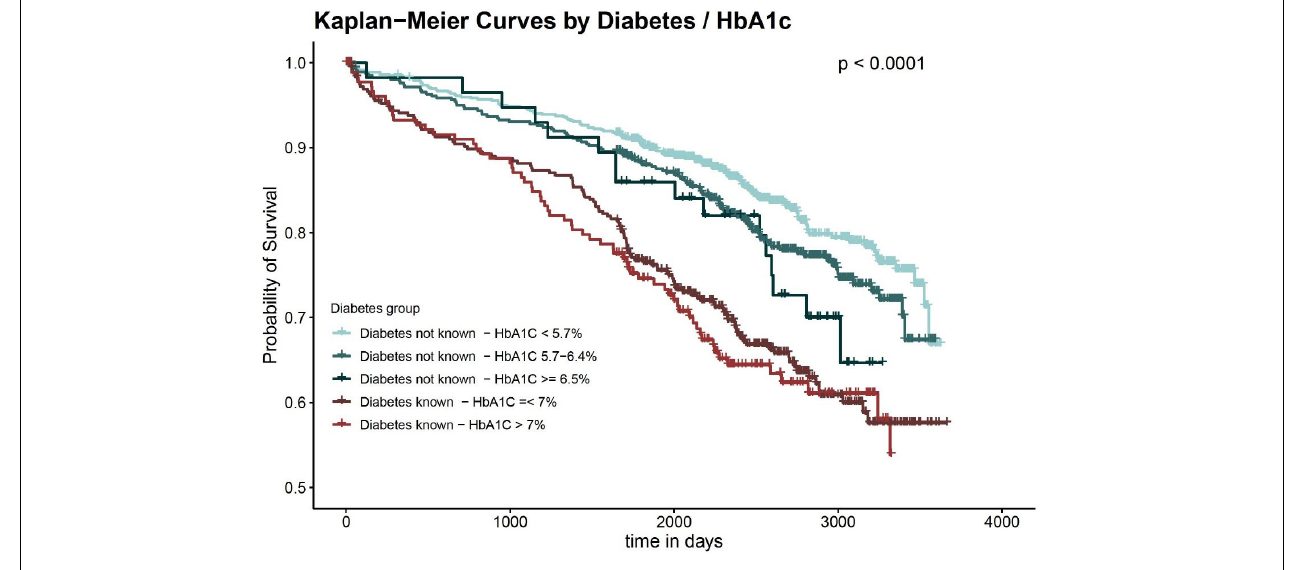
FIGURE 2 | Long-term survival by diabetes status and HbA1c values. TABLE 2 | Results of the COX regression